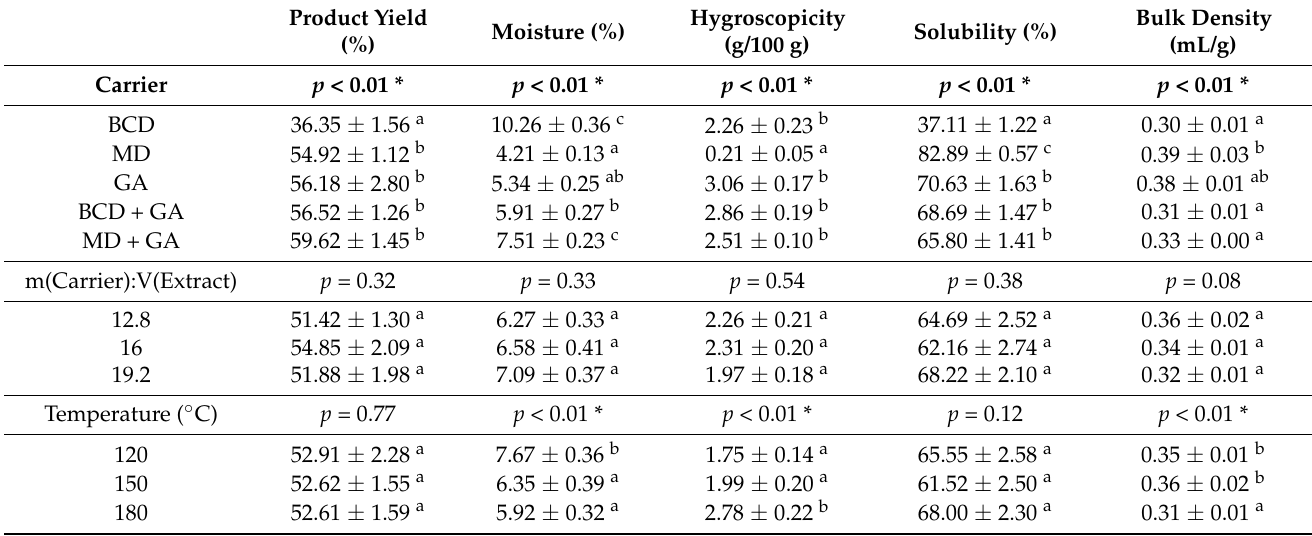
Table 2. Influence of carrier type, carrier concentration in feed solution and inlet temperature on the product yield, moisture content, hygroscopicity, solubility and bulk density of produced powders.